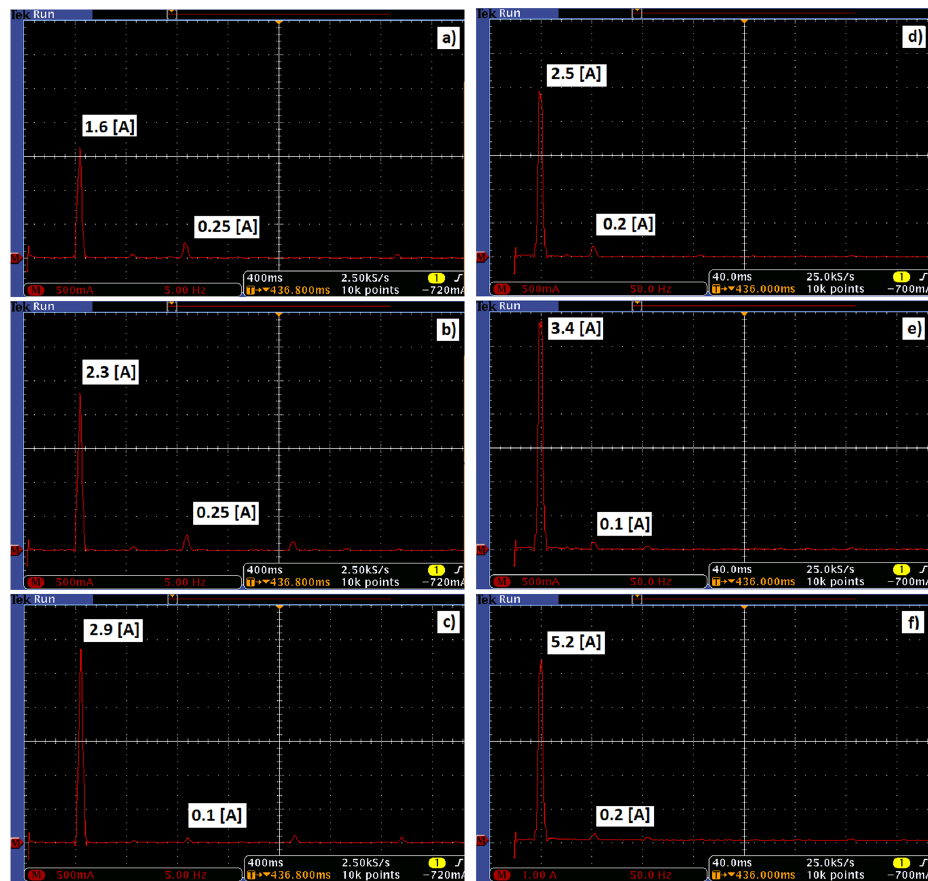
Figure 5. Current spectra recorded with an oscilloscope for phase B at no ‐ load motor operation in the following cases: ( a ) motor operating with all phases at 150 rpm, ( b ) motor operating without phase A and at 150 rpm, ( c ) motor operating without phases A and C at 150 rpm, ( d ) motor operating with all phases at 750 rpm, ( e ) motor operating without phase A at 750 rpm, ( f ) motor operating without phase A and C at 750 rpm.